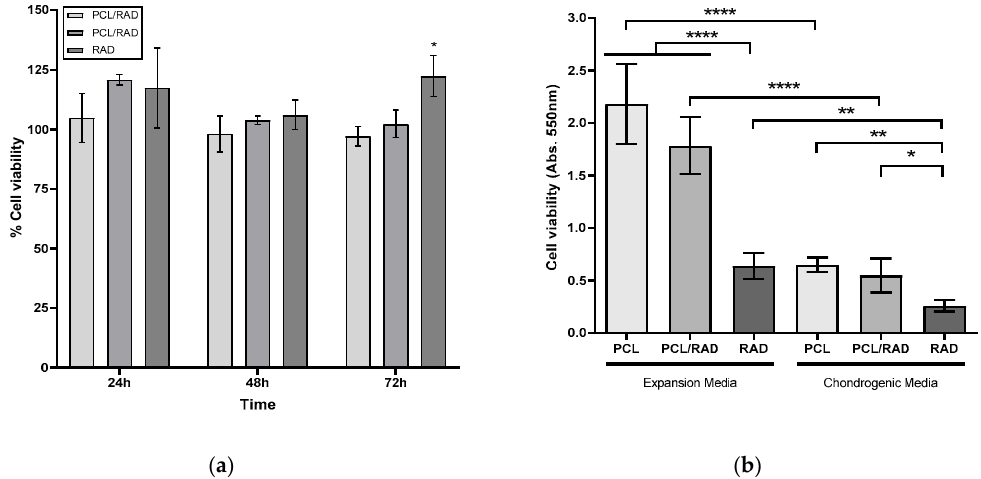
Figure 2. MTT assay for material cytotoxicity and metabolic activity. ( a ) PCL, PCL/RAD and RAD cytotoxicity determination after 24, 48 and 72 h. MTT values were expressed in number of cells. ( b ) Cellular metabolic activity results from hMSCs’ 30-day culture. MTT values were expressed as a measure of formazan (product) absorbance at 550 nm. (Statistical differences are indicated as: * p < 0.05, ** p < 0.01, *** p < 0.001 and **** p < 0.0001, N = 3, one-way ANOVA). n = 3.